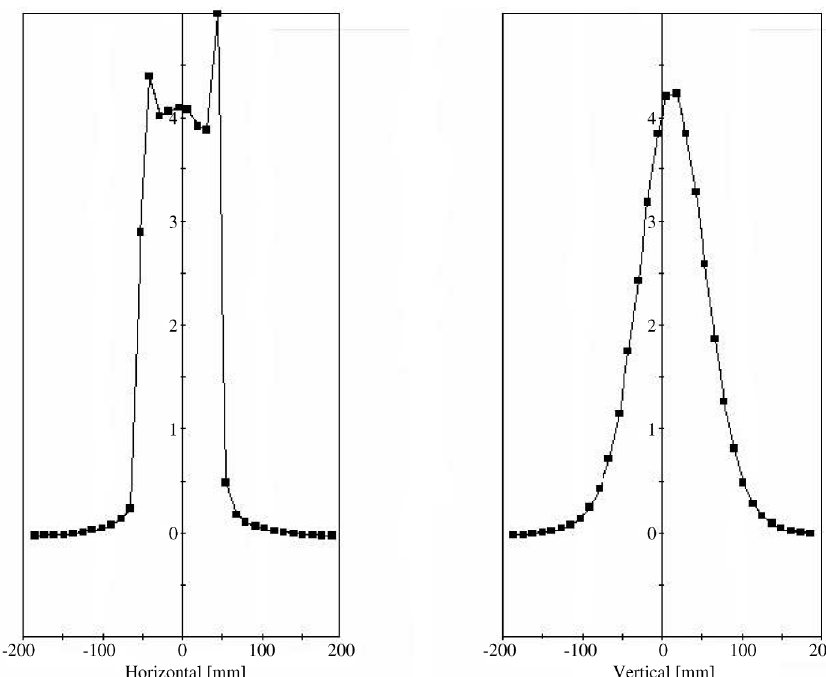
FIG. 11. Horizontal and vertical beam profiles at the target of the NSRL line with only the horizontal octupole (O1) ON. Note that only the horizontal profile is affected by the octupole (O1), with the vertical profile remaining unaffected and maintaining a Gaussian